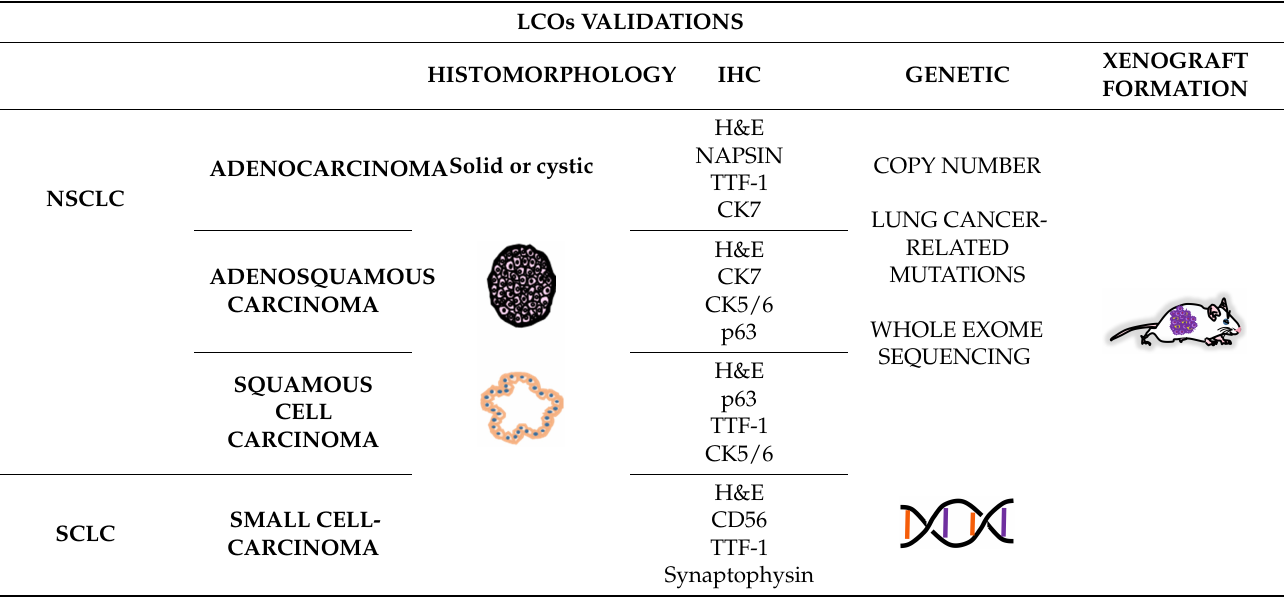
Table 3. Multi-step validations proposed to assess LCO purity. SCLC, small-cell lung cancer; NSCLC, non-small-cell lung cancer; H&E, hematoxylin/eosin staining; CK7, Cytokeratin 7; CK5/6, Cytoker- atin 5/6; TTF-1, Thyroid Transcription Factor-1; CD56, cluster of differentiation 56, IHC, immunohis- tochemistry. The table reports information